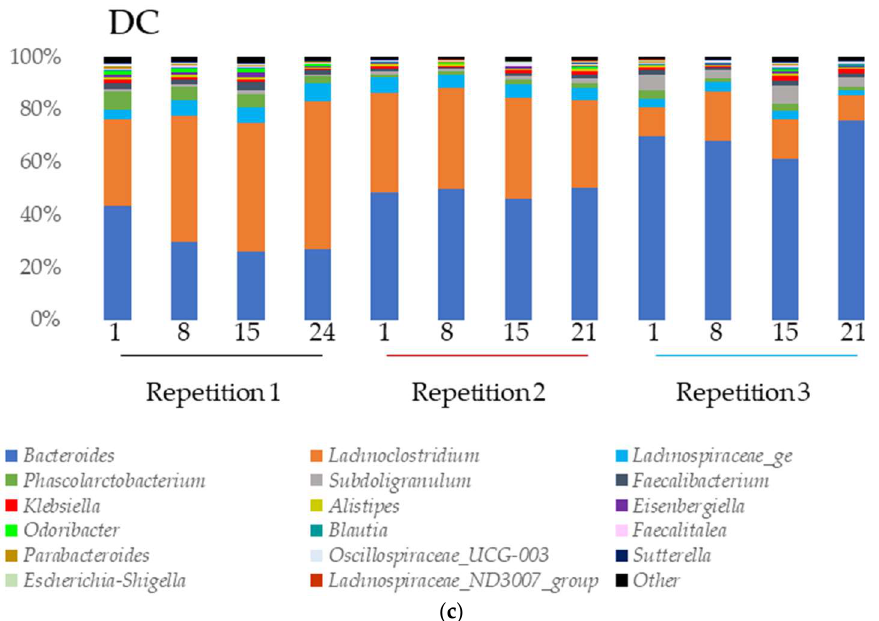
Figure 6. Microbial community analysis in ascending (AC) ( a ), transverse (TC) ( b ) and descending (DC) ( c ) colons assessed by 16S rRNA Illumina Sequencing after one daily ULIP33 phage injection (10 mL at 10 9 PFU/mL) in the ascending colon for 7 days. Relative abundance (in %) histogram at genus level. Black line: repetition 1; burgundy line: repetition 2 and light blue line: repetition 3.